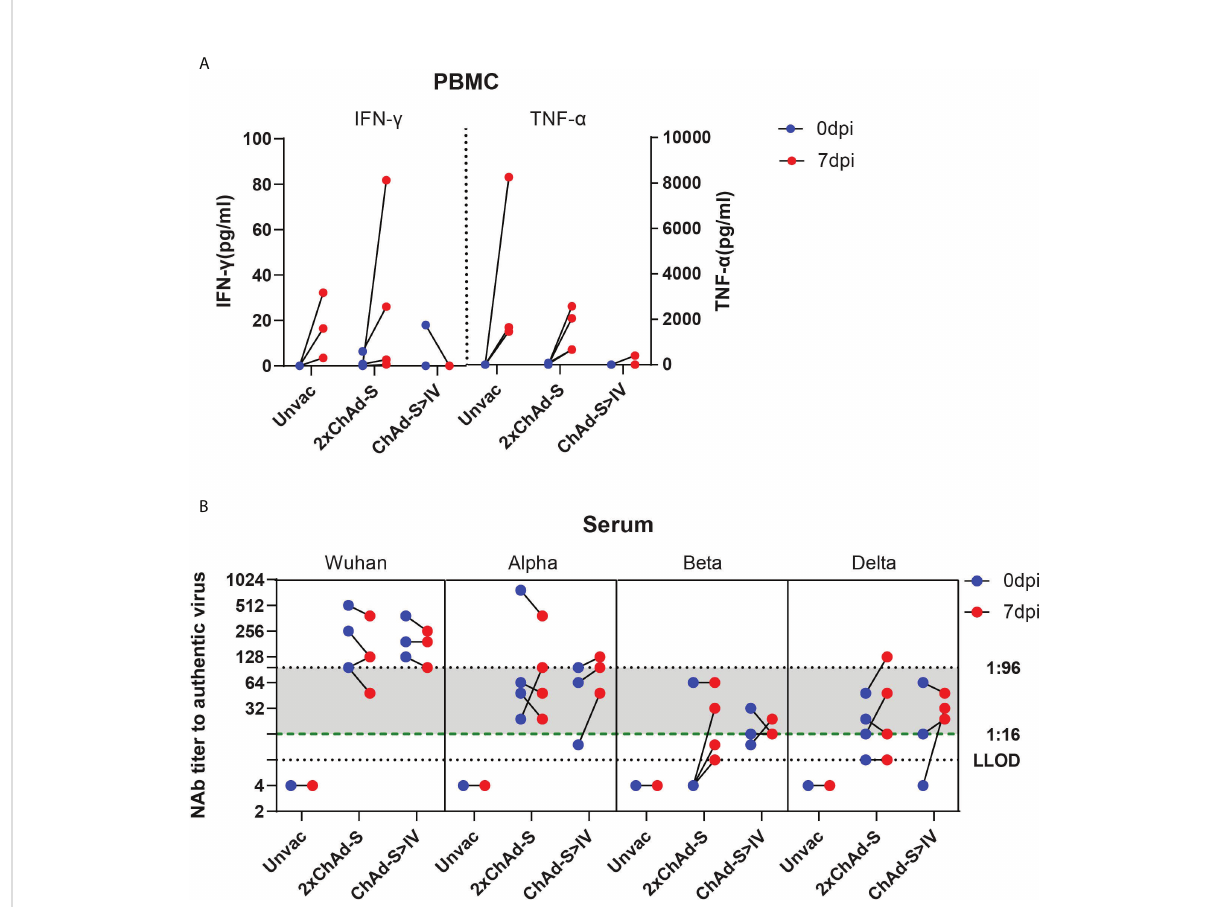
FIGURE 5 Recalled immune responses after challenge in different vaccine groups. (A) PBMCs were isolated before (0 dpi) and after (7 dpi) challenge, and stimulated by spike peptide pool. INF- g concentration of supernatant was quanti fi ed and expressed as pg/ml. (B) Serum neutralizing antibody titer against different VOCs before (0 dpi) and after (7 dpi) Beta variant challenge. One spot represents one